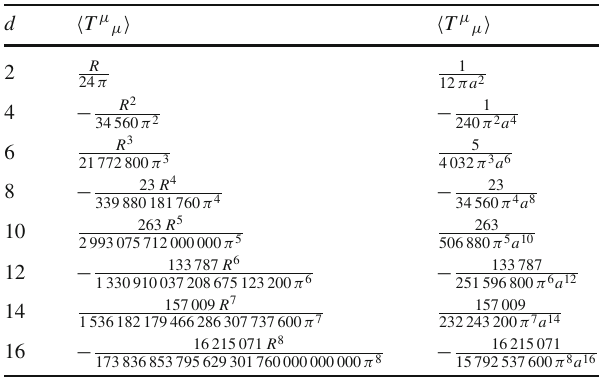
Table 1 Type-A trace anomalies of a conformal scalar